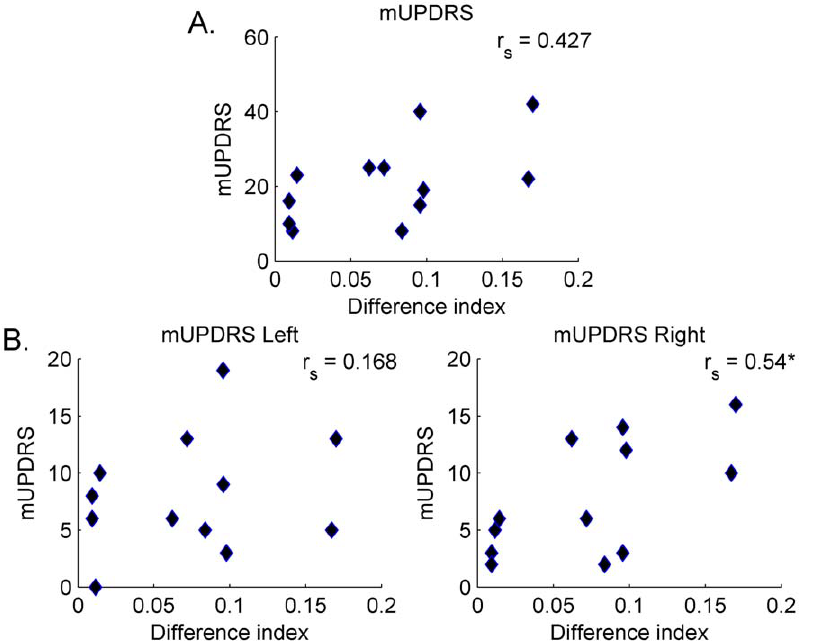
Figure 4. Scores of the difference index for each patient plotted against his/her total motor UPDRS score. (A) and against a composite scores for all left- and right-sided motor UPDRS items (B). * Statistically significant at p , 0.05.